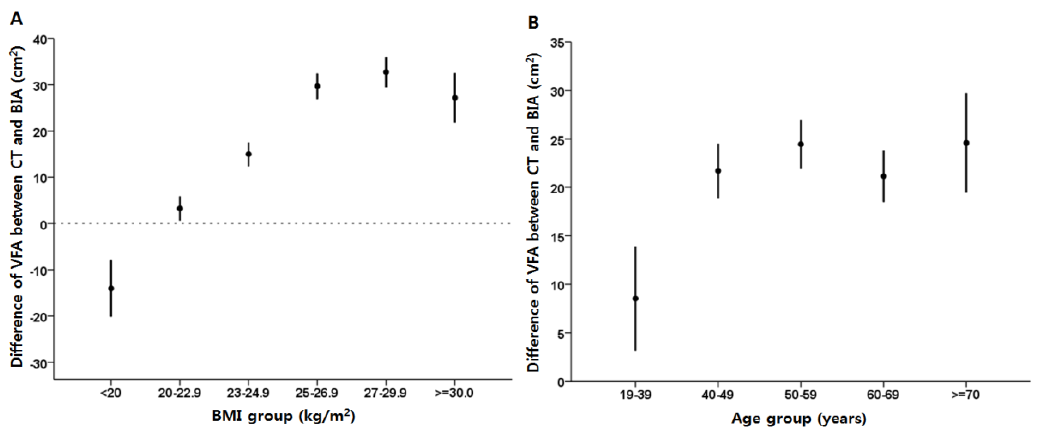
Figure 2. Differences in VFA between CT and BIA methods according to BMI ( A ) and subjects age ( B ).